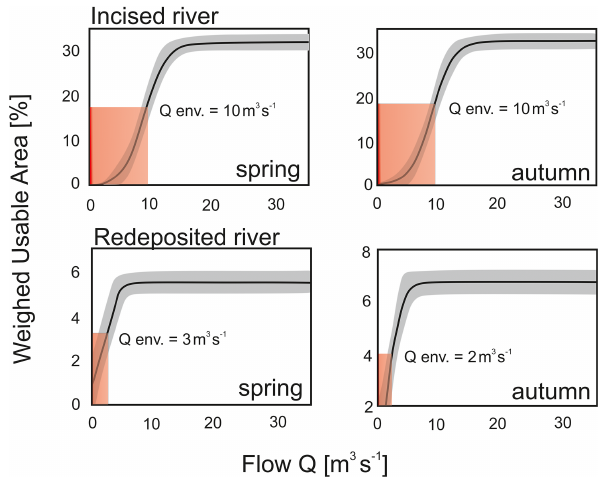
Figure 7. Weighted usable area (WUA)–flow relation curves (spring and autumn season) of the rivers varying in bed modification: Raba River with incision and Ropa River with redeposition.